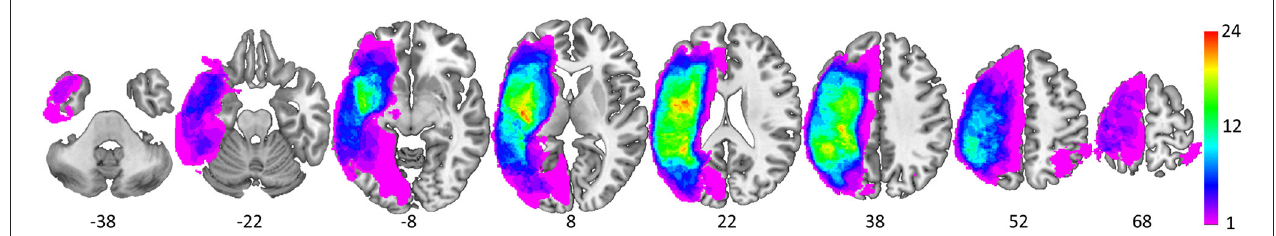
FIGURE 3 | Spatial distribution of the 37 lesions as depicted via equally spaced (16mm) axial slices (MNI z coordinate below each slice). The color scale denotes the number of overlapping lesions at each voxel.